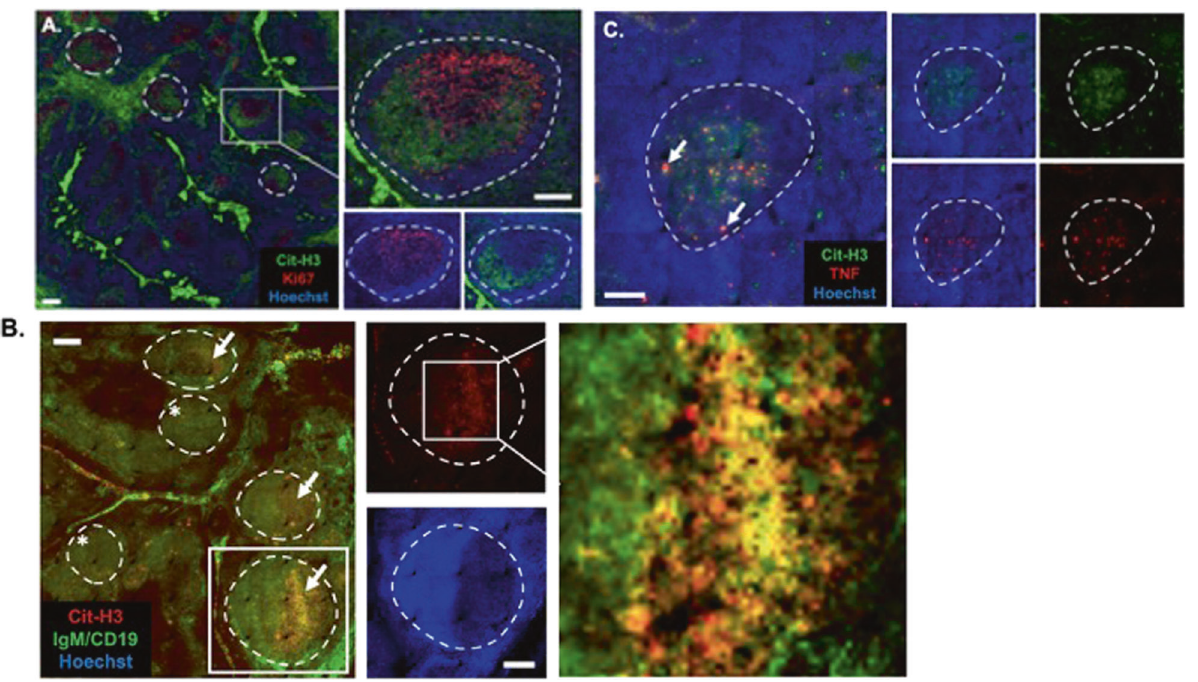
Fig. 4 Hyper-Cit-H3 in tonsil tissue. Immuno fl uorescence on cross sections of human tonsil. Scale bar = 200 μ m. A Hyper-Cit-H3 and Ki67. B cell follicles highlighted with dashed lines. Square is expanded and shown with single color in lower right. B Hyper-Cit-H3 and B cell markers CD19/IgM. Arrows point to areas with high HyperCit-H3 signal (GC). Asterisks indicate primary B cell follicles. Square is shown on right with single stain, Cit-H3 (top) or Hoecht (bottom). Far-right panel shows overlapping hyper-Cit-H3 and IgM/CD19 signal (yellow). C Hyper-Cit-H3 and TNF. Arrows show areas with overlapping hyper-Cit-H3 and TNF signal. Right panel shows single color images of Cit-H3 (top) and TNF (bottom) with and without the nuclear stain Hoechst. Data are representative of 4